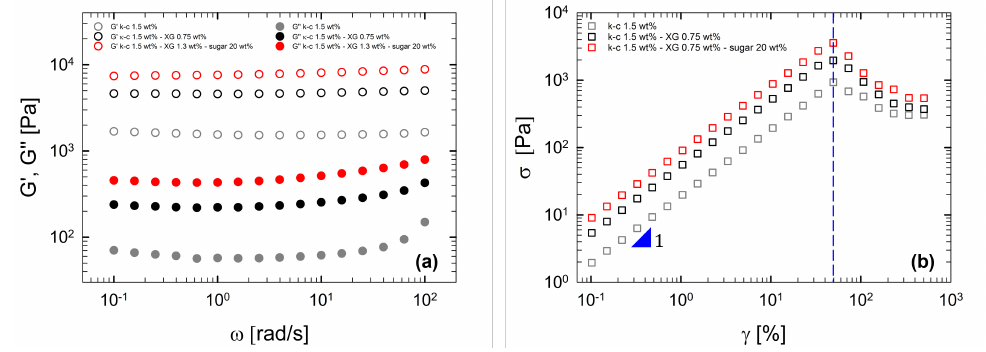
Figure 12. ( a ) Viscoelastic moduli as a function of the angular frequency at 20 ◦ C, and ( b ) shear stress as a function of the shear strain at 20 ◦ C. The dashed line indicates the yield point of the gel. Details on samples are reported in the legend. Table 3. Values of yield stress and yield strain evaluated at 20 ◦ C, for selected binary, ternary, and quaternary